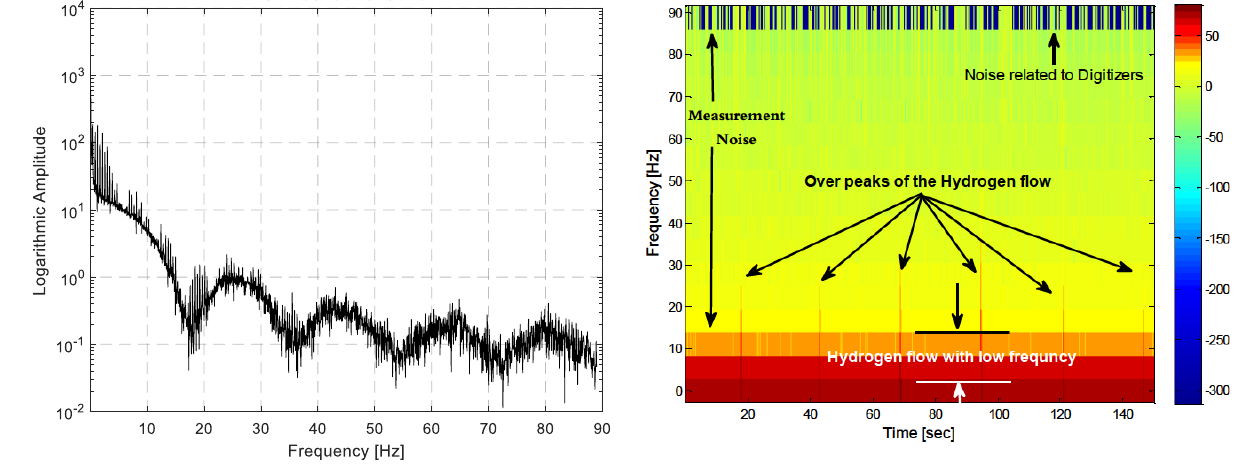
Figure 7: Spectrogram of the hydrogen flow.